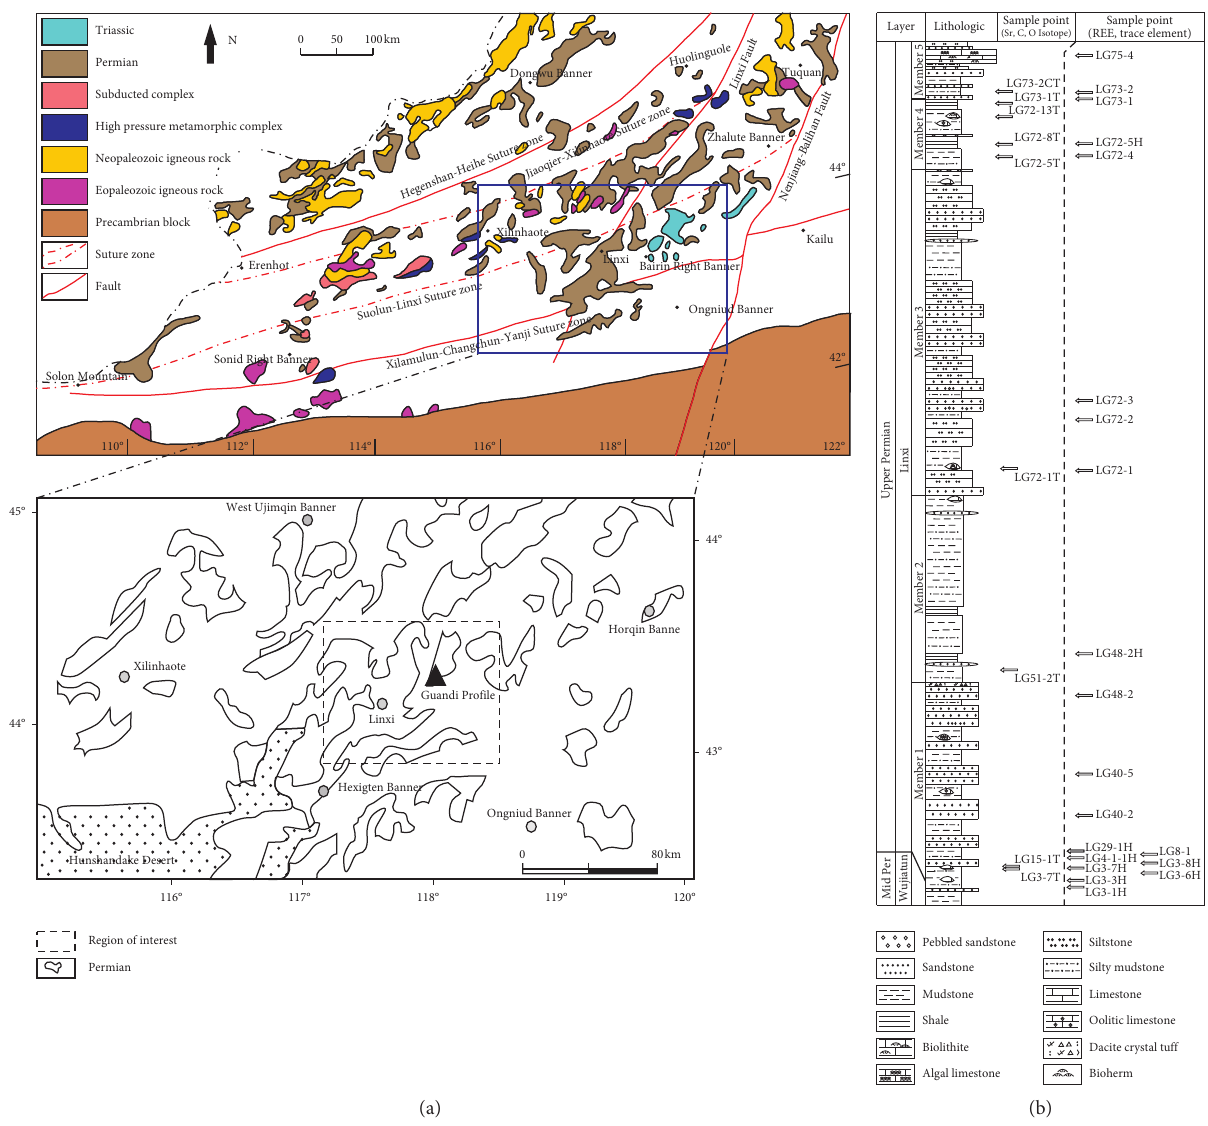
Figure 1: Tectonics and stratigraphy of eastern Inner Mongolia: (a) tectonic belt, stratum plane distribution, and the location of Guandi profile in the Linxi area; (b) the lithological section and sample distribution of Linxi